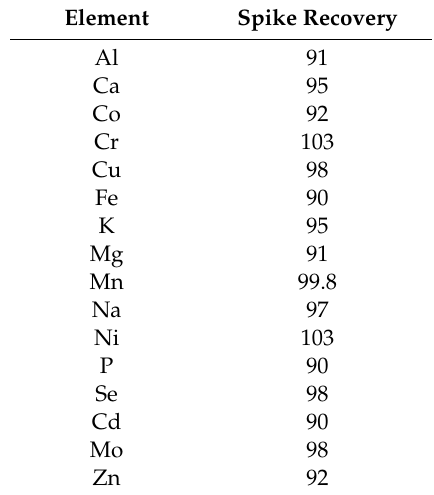
Table 5. Recoveries for spiked babassu oil (%).